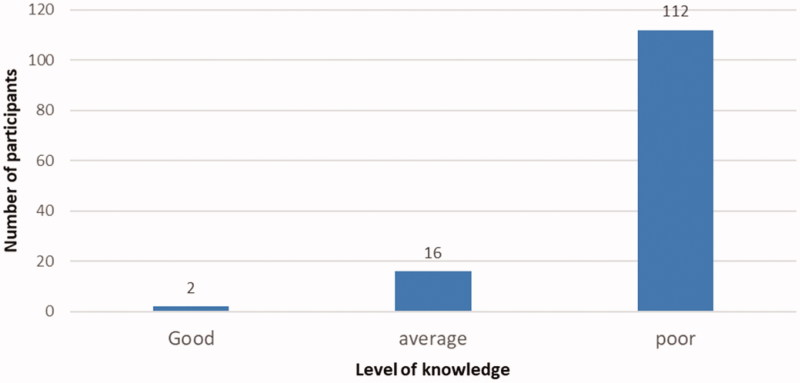
Distribution of level of knowledge on CKD in the study population.